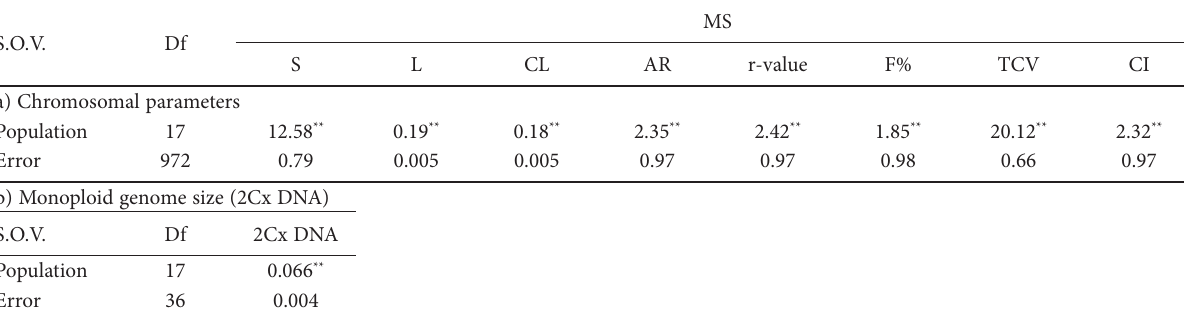
Table 2. ANOVA of chromosomal parameters (a) and monoploid genome size (2Cx DNA; b) of Ferula assa-foetida L.